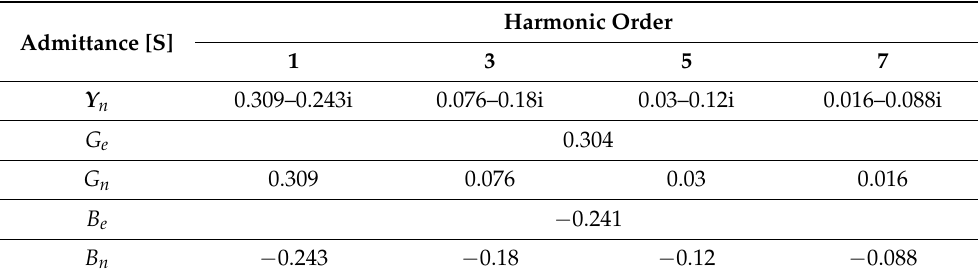
Table 2. List of equivalent values of the load’s parameters.